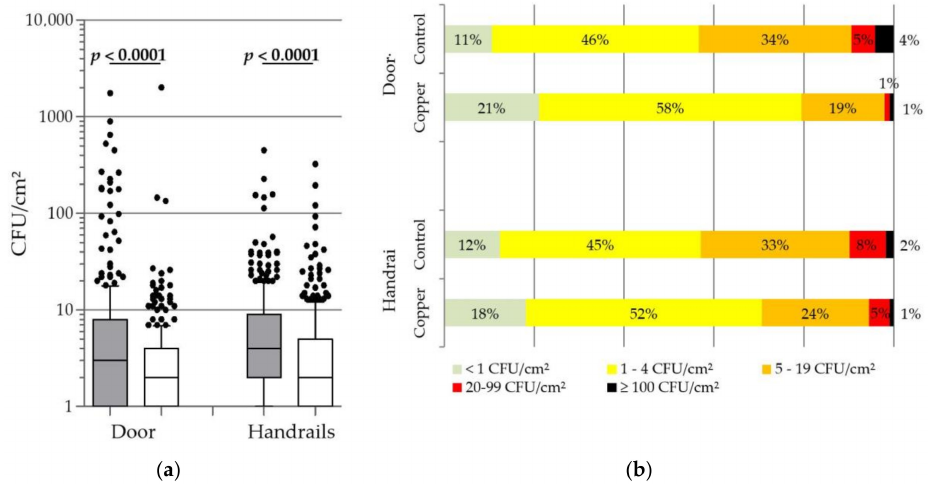
Figure 1. Distribution of the environmental bacterial burden found on touch surfaces. Overall compilation for the five long term care facilities. ( a ) Box plot representation of all the values. Grey boxes, control; White boxes, copper. Horizontal line in box, median; Boxes extremities, 1–4 quartiles; Whiskers, 10–90 percentiles; dots, 10% highest values; Significant p -value of Mann-Whitney U test are noted in bold. ( b ) Frequency distribution of the bacterial burden concentration (%). Door handles: n = 341. Handrails: n =